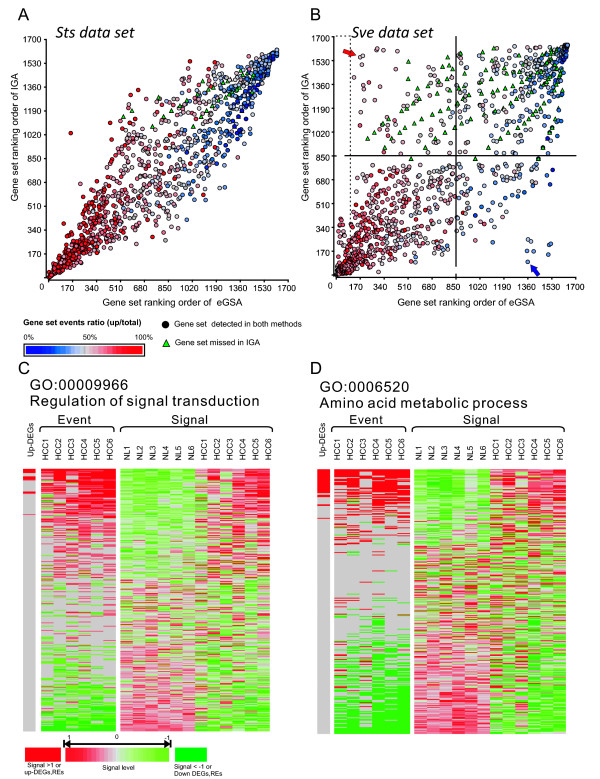
Correlations between eGSA and IGA. (A) and (B), Scatter plots of GS significance ordered by eGSA (y-axis) and IGA (x-axis). Each circle represents one GS, and green triangles represent missed GSs in IGA. The color represents the percentage of up-regulated REs in a GS (REup in GS/REtotal in GS). Most GSs in Sts are correlated and aligned on the diagonal line. In Sve, the high- and low-rank GSs are also correlated but many GSs appear inconsistent (in 2nd and 4th quadrant). Their gene changes of two extremely inconsistent GSs, which are indicated by red and blue arrows, are further shown in (C) and (D). In these heatmaps, each row represents one gene in a GS while each column represents a tissue sample. The first column is the up-DEGs detected by IGA (shown in red). The event panel is REs detected by eGSA (red: up-REs; green: down-REs), while the signal panel is the standardized (mean = 0, SD = 0.5) microarray signals of all samples. The signal level is presented by the color scale (red: up-regulation; green: down).